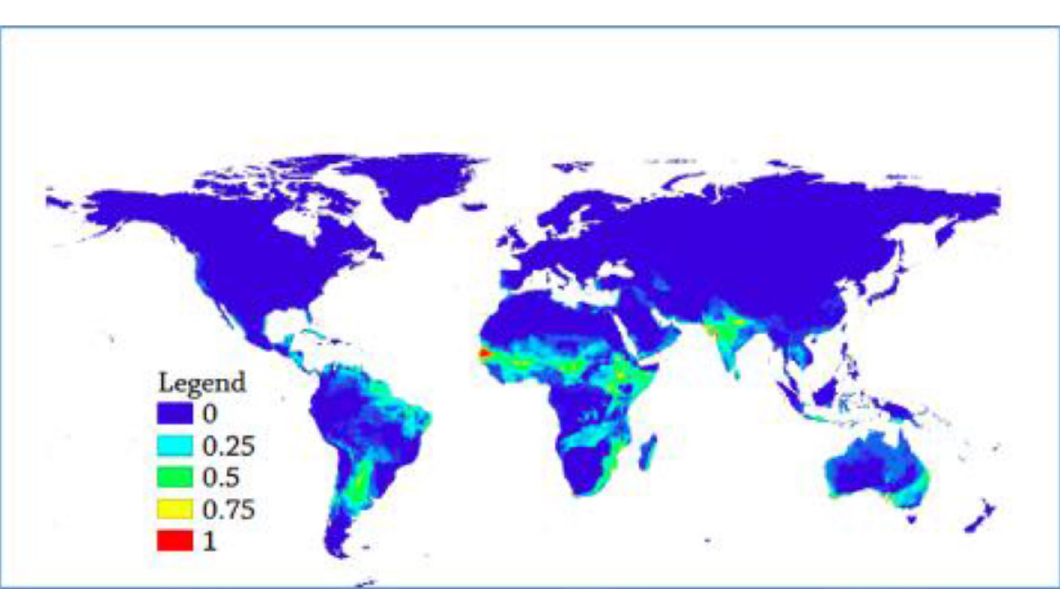
Figure 2. Weighted Mean global suitability depiction of AHS. (The warmer colors depict highly suitable territories while cooler colors depict non suitable